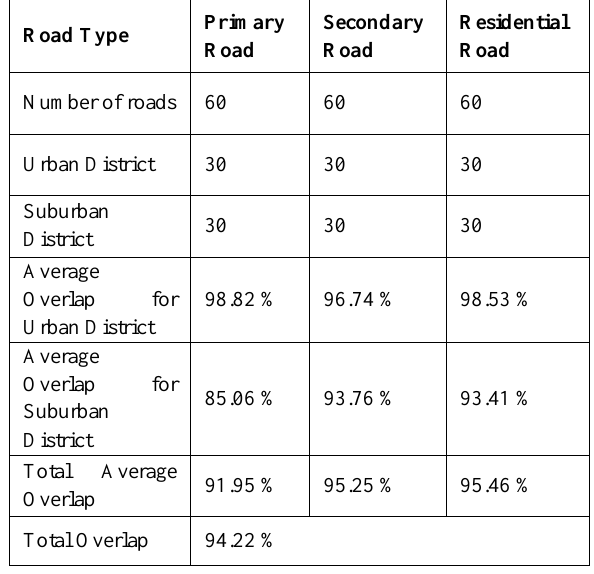
Table 3: Comparison of overlaps according to the type of roads